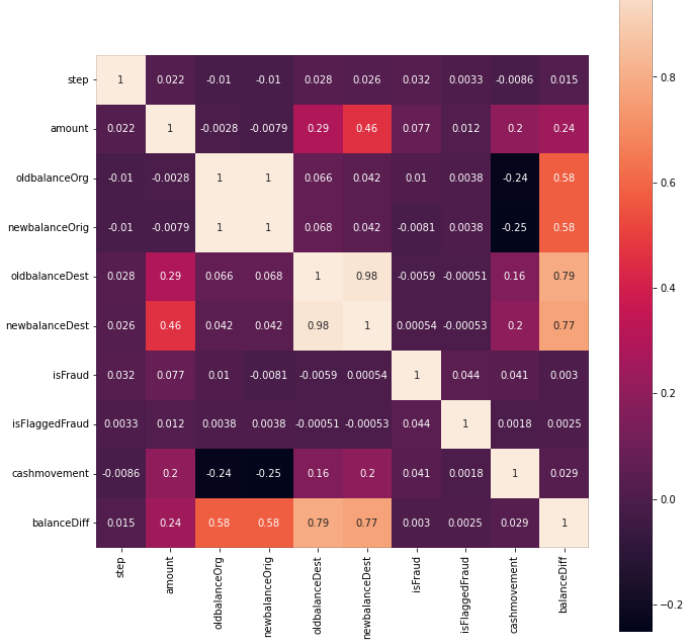
Figure 2. Correlation Matrix of Original Dataset.